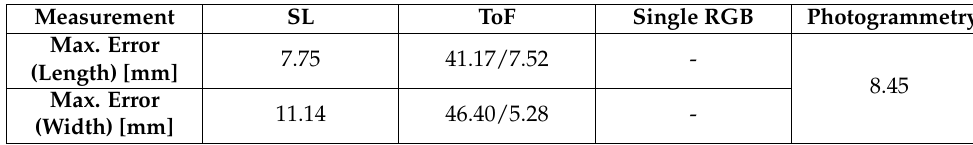
Table 3. Comparison of the shape comparison results.